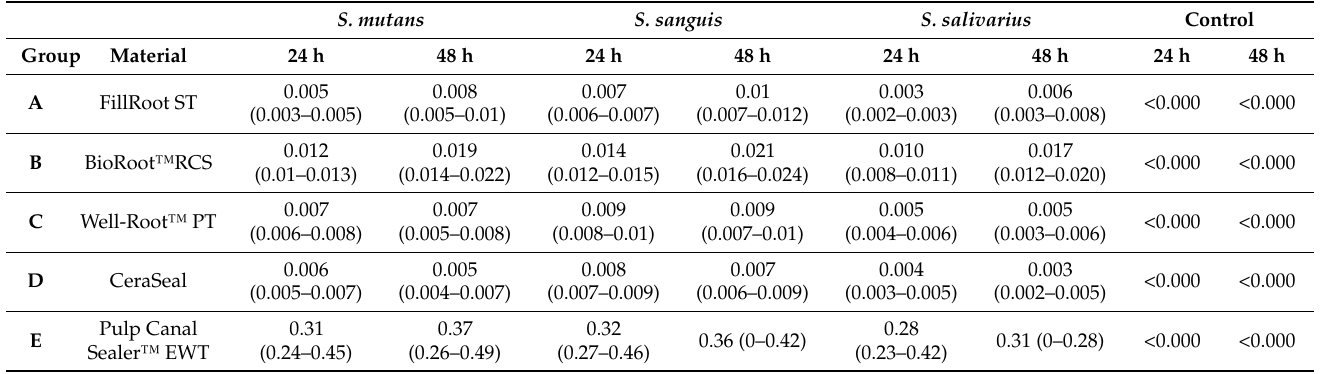
Table 2. Median (minimum-maximum) of growth inhibition results (mm) of the different root canal